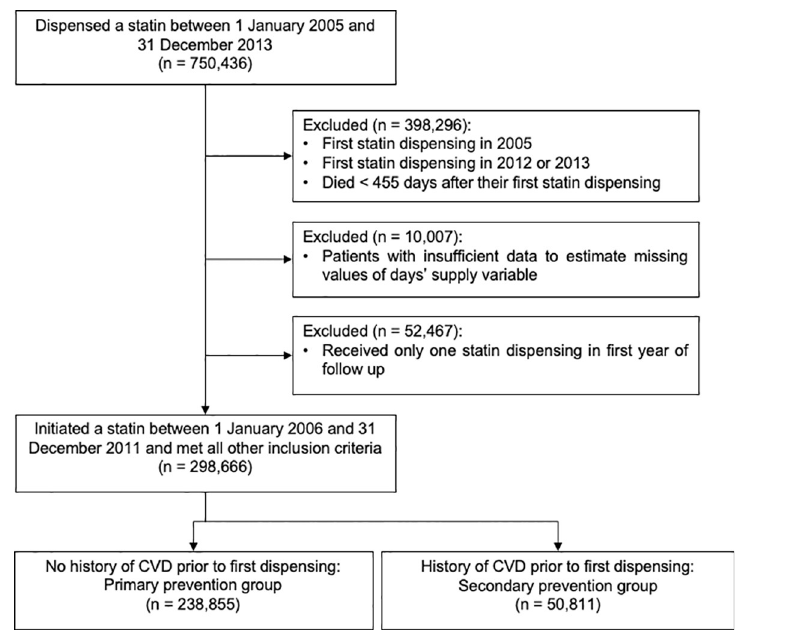
Fig 1. Identification of the study